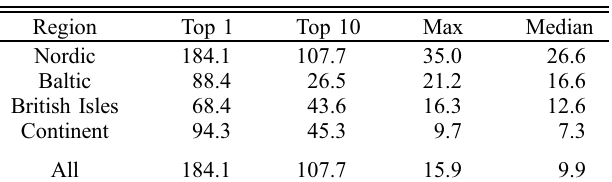
Table 3. As Table 2 but assuming a single ground conductivity model of Table 1 everywhere.